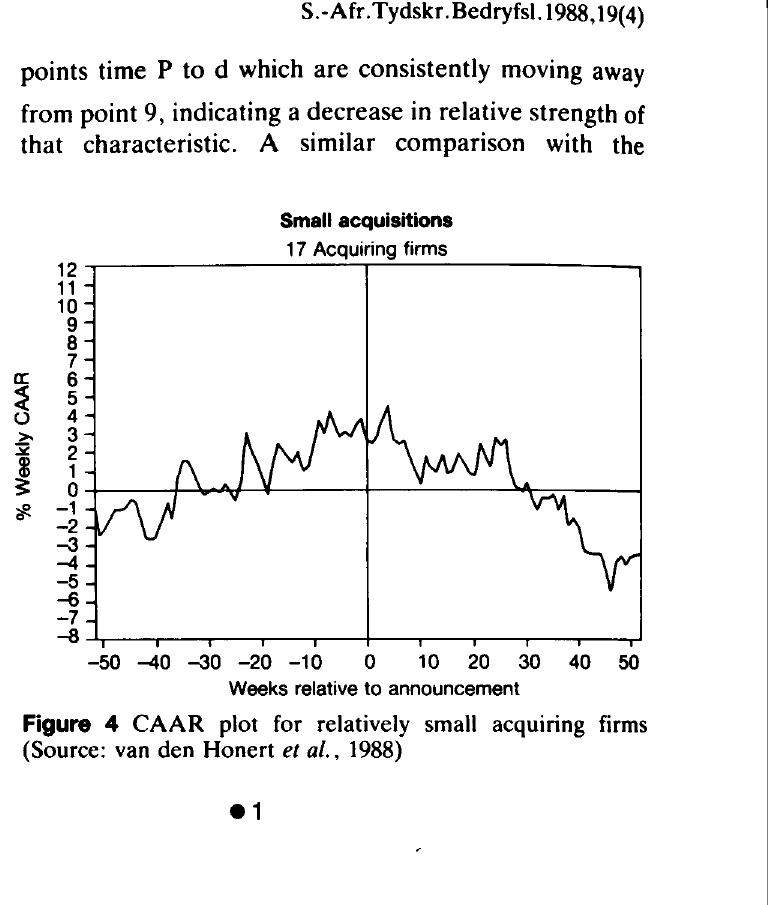
Figure 5 Covariance biplot for two levels of five characteristics of target firms over the period 15 months prior to merger until three months after